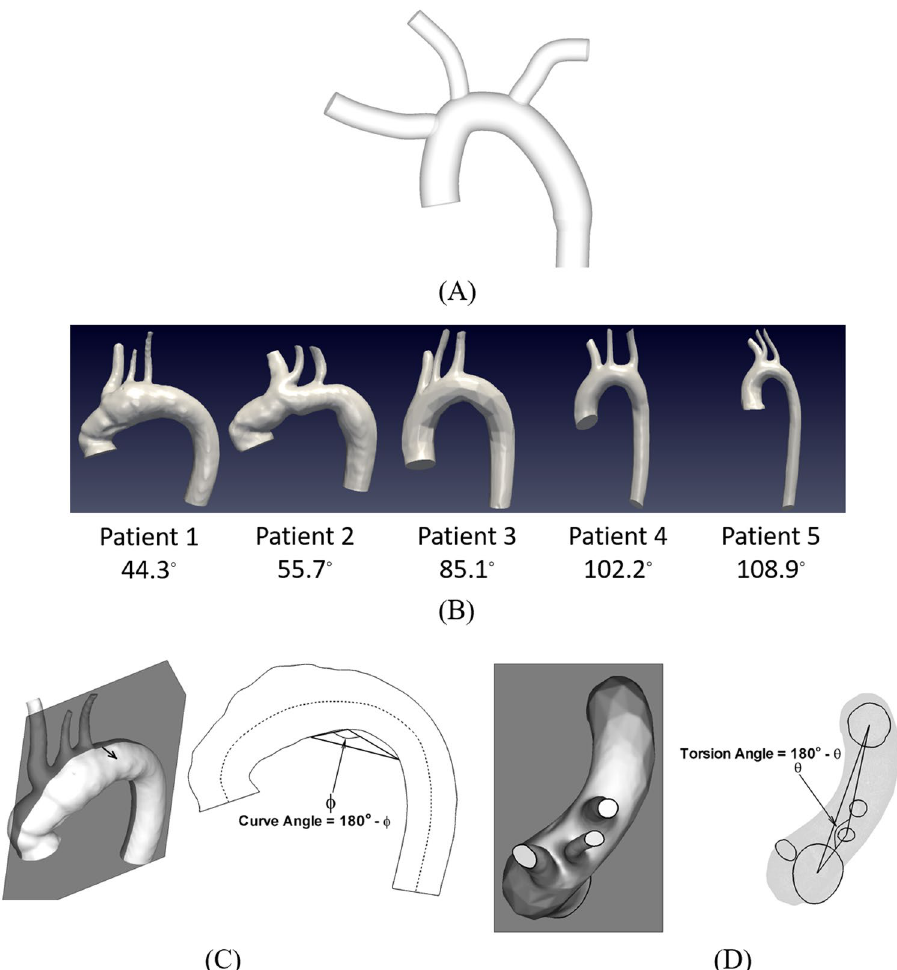
Figure 1. ( A ) Idealized aortic arch model. ( B ) Aorta models reconstructed from computed tomography (CT) scan images. The label indicates a curvature angle in each patient which is defined as sum of curve and torsion angles and indicative of global 3D curvature of aorta. ( C ) Curve angle of aorta or 180° − φ is defined as an angle made at the peak position of the inner aortic curve as projected onto the rough mid-plane passing through two centroid points of ascending aorta inlet and descending aorta outlet based on the previous study 35 . The black arrow in the left panel denotes a normal vector perpendicular to the mid-plane. Dashed line indicates a rough center line of aorta. ( D ) Torsion angle or 180° − θ which is defined as an angle at the left common carotid artery that is made by connecting three centroid points of ascending aorta, left common carotid artery, and descending aorta as projected in the descending aorta